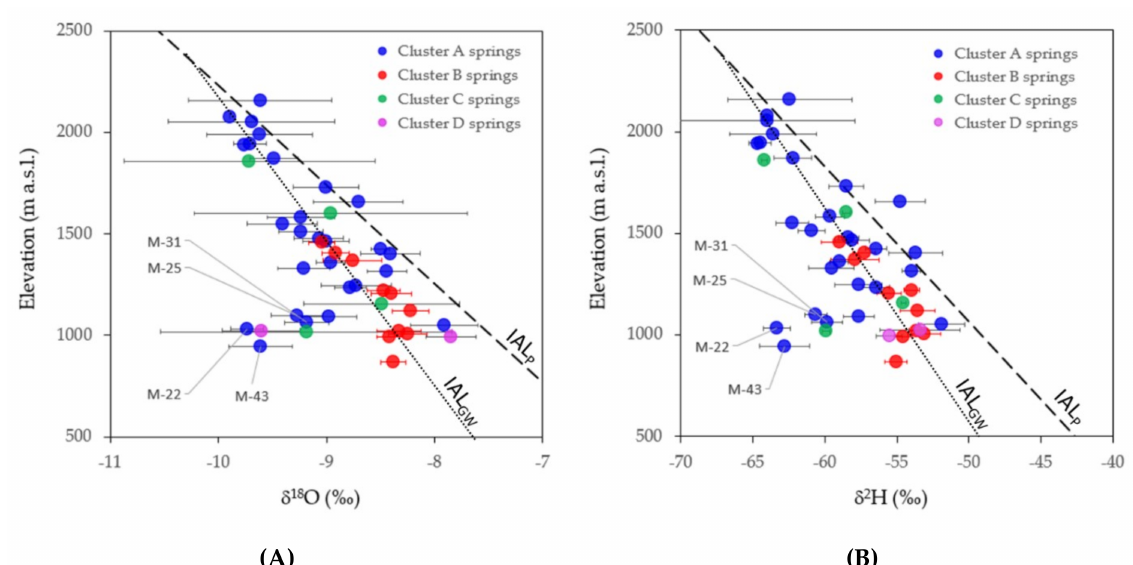
Figure 7. Relationship between elevation, the isotopic content in GW, and the isotopic altitudinal line defined by Herms et al. (2019) [29]. The dashed and dotted lines correspond to the isotopic altitudinal lines of precipitation (IAL P ) and groundwater (IAL GW ), respectively. ( A ) δ 18 O, and ( B ) δ 2